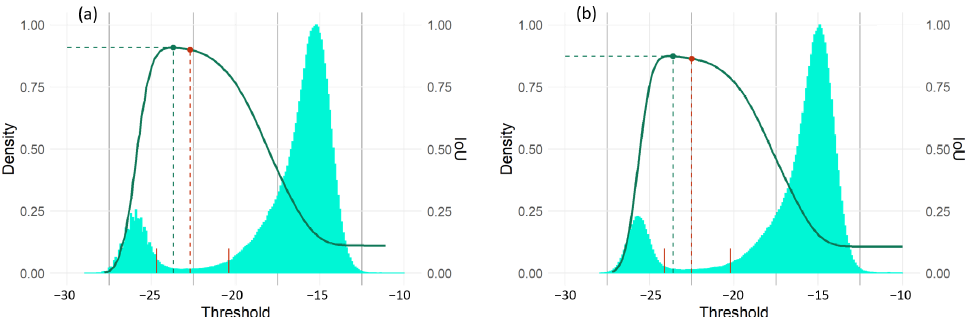
Figure 13. Visualization of optimal thresholds determined by the proposed method (green dotted line) and by the Otsu method (red dotted line) on IoU curves and histograms σ 0 ( a ) MNDWI Median 7 × 7; ( b ) NDWI Lee 7 ×